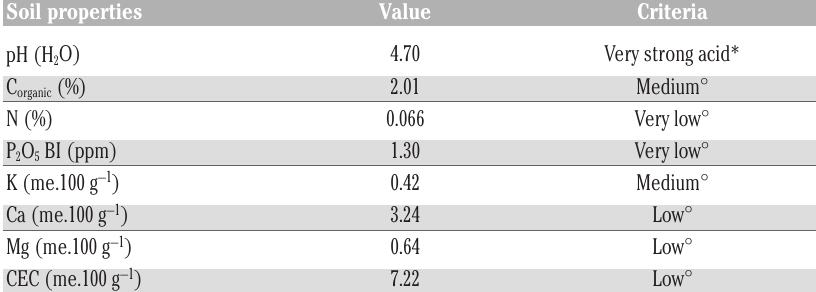
Table 1. Soil properties of Restu Baru village, Rumbia Regency, Central Lampung, Indonesia. Soil properties